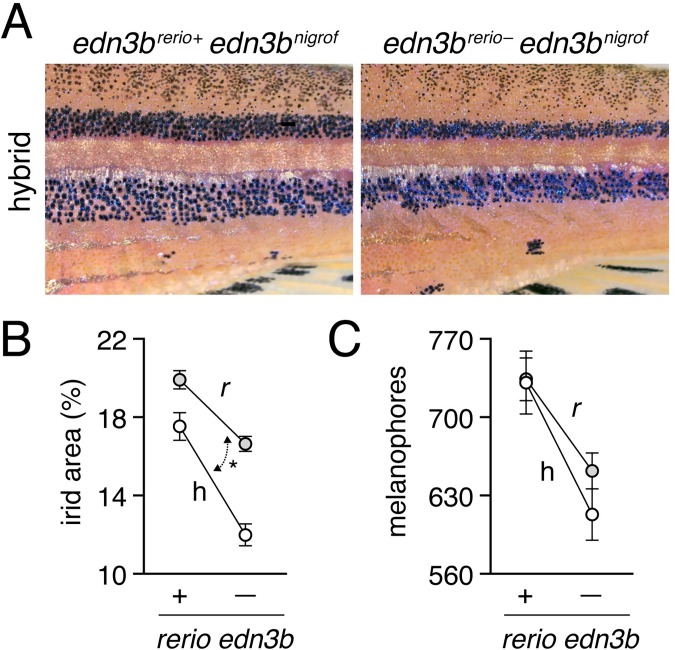
Hypomorphic edn3b allele in D. nigrofasciatus relative to D. rerio.(A) Interspecific hybrids carrying either D. rerio wild-type edn3b allele (left) or mutant edn3b allele (right). Carriers of the mutant allele tended to have narrower stripes and reduced iridophore coverage overall. (B) Hybrids (h) had reduced coverage by dense iridophores of interstripes (total percent of flank) compared to D. rerio (r) overall (F1,59 = 21.7, P<0.0001). Iridophore coverage was also reduced by substitution of a D. rerio edn3b mutant allele (–) for the D. rerio wild-type allele (+; F1,59 = 101.6, respectively; both P<0.0001), but this effect was more pronounced in hybrids, resulting in a significant background x allele interaction (F1,59 = 6.5, P<0.05; double headed arrow, different slopes). (C) Numbers of hypodermal melanophores were affected by background and D. rerio allele (F1,61 = 23.5, F1,61 = 24.7, respectively; both P<0.0001), but a background x allele interaction was non-significant (F1,59 = 1.0, P = 0.3). Plots show least squares means±SE after controlling for significant effects of SL (P<0.05, P<0.0001, respectively). Sample sizes (N): 17 D. rerio (+); 24 D. rerio (–); 10 hybrids (+); 13 hybrids (–).